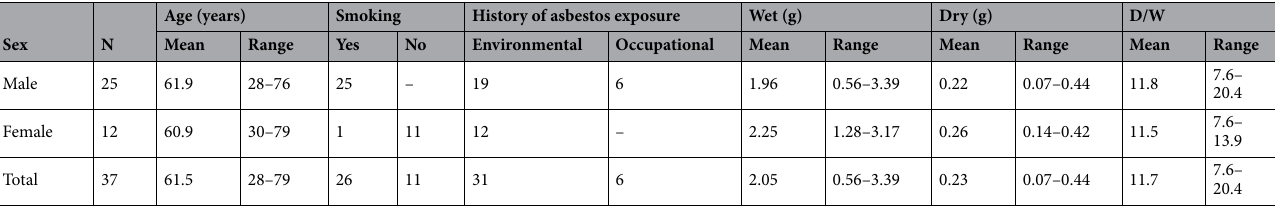
Table 1. Clinicodemographic patient